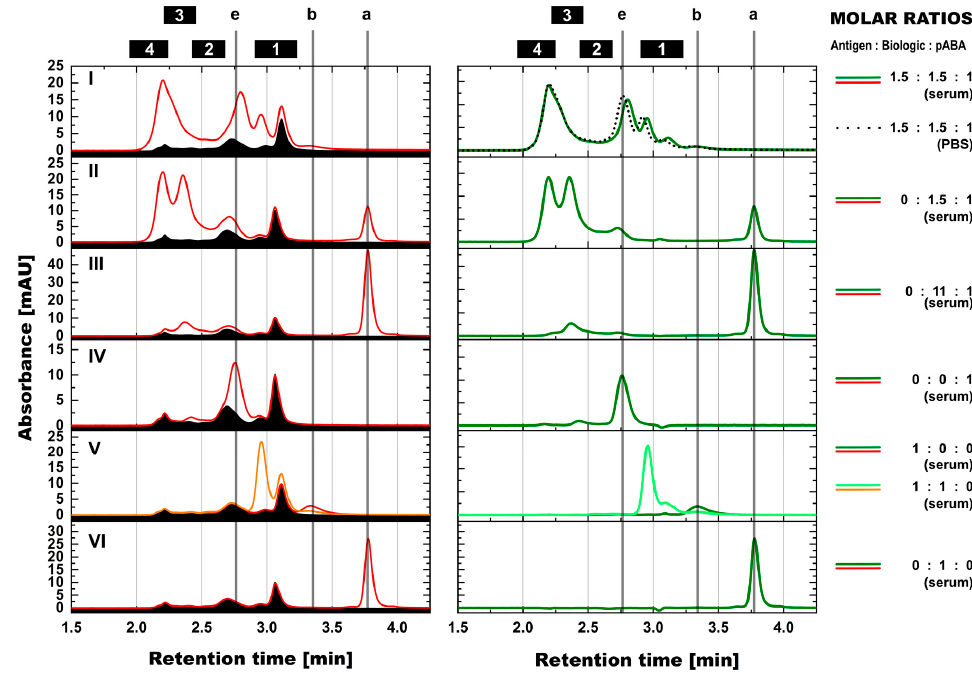
Figure 8. Assessment of immune complex formation in mouse serum background by SEC. SEC profiles of diluted mouse serum represented by black area under the curve and samples in diluted mouse serum by red lines (left panels), and profiles of differential representation of both after subtraction of serum matrix by green lines (right panels). Antigen:biologic:pABA compositions of the following molar ratios are shown—1.5:1.5:1 on panel ( I ), 0:1.5:1 on panel ( II ), 0:11:1 on panel ( III